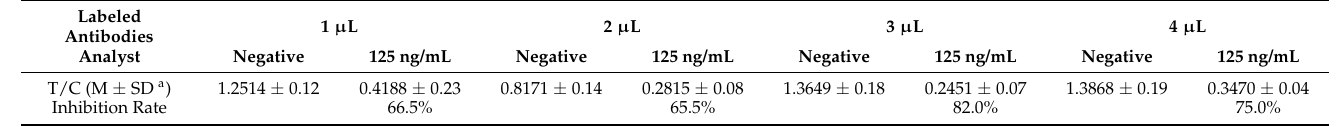
Figure 4. Dosage selection of the labeled antibodies for tylosin ( n = 3). (Concentration of coating antigen and second antibody are 1 mg/mL and 0.093 mg/mL.) Table 1. Dosage selection of the labeled antibodies for tylosin ( n =